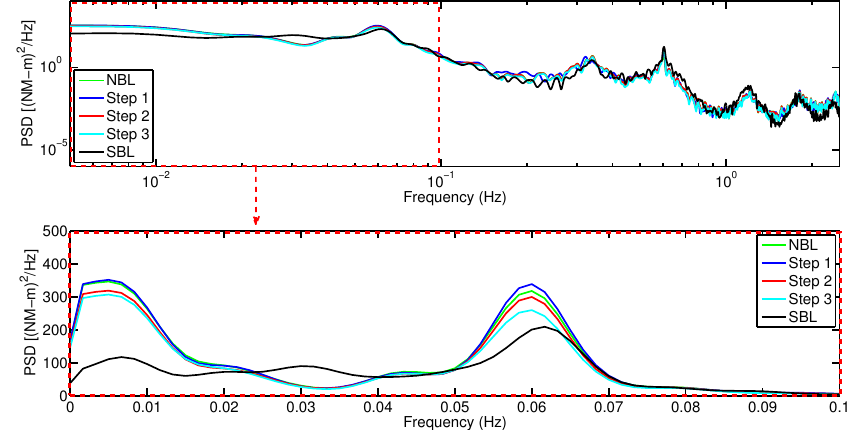
Figure 16. Comparison of FATBM power spectra for a single case